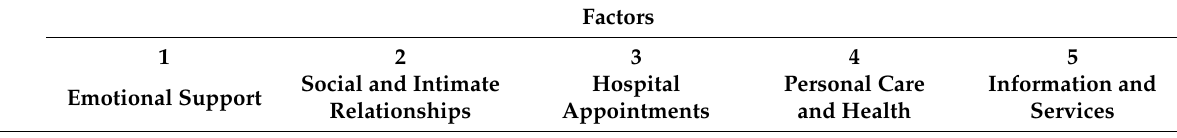
Table 4. Exploratory factor analysis of the needs assessment tool for breast cancer